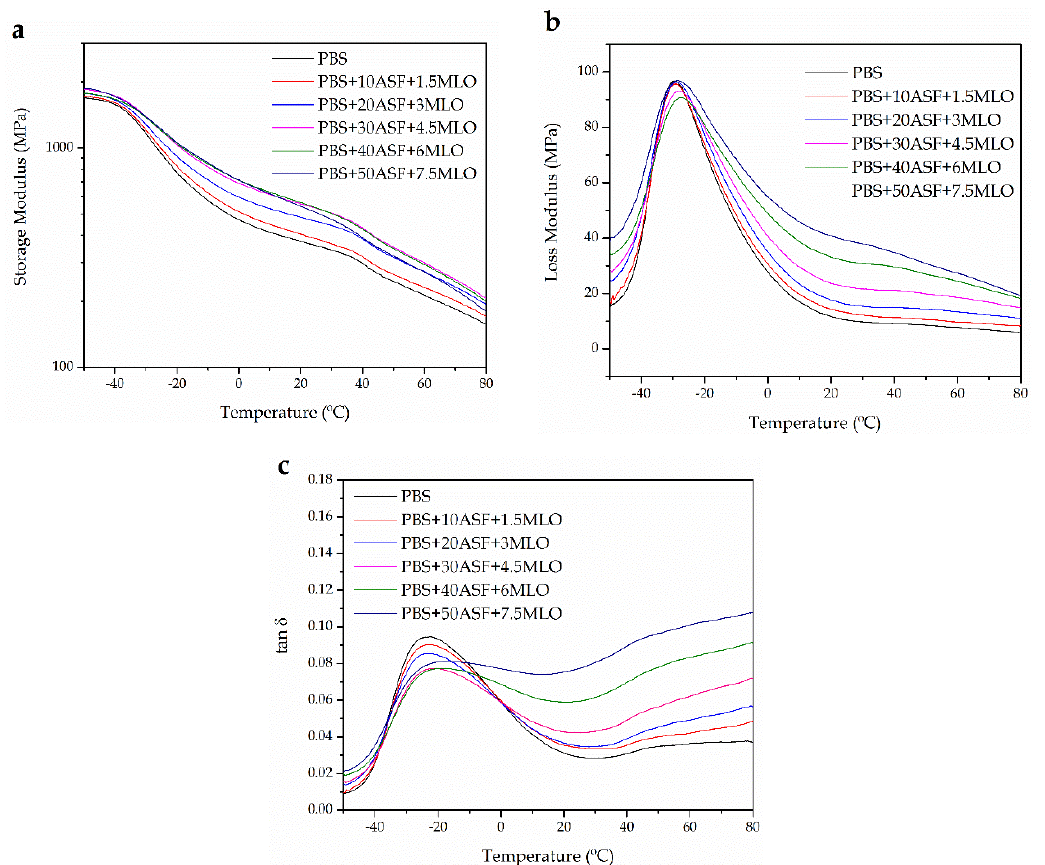
Figure 6. Plot evolution of ( a ) storage modulus ( E’ ), ( b ) loss modulus ( E” ), and ( c ) damping factor ( tan δ ) of PBS/ASF/MLO composites with varying ASF loading.